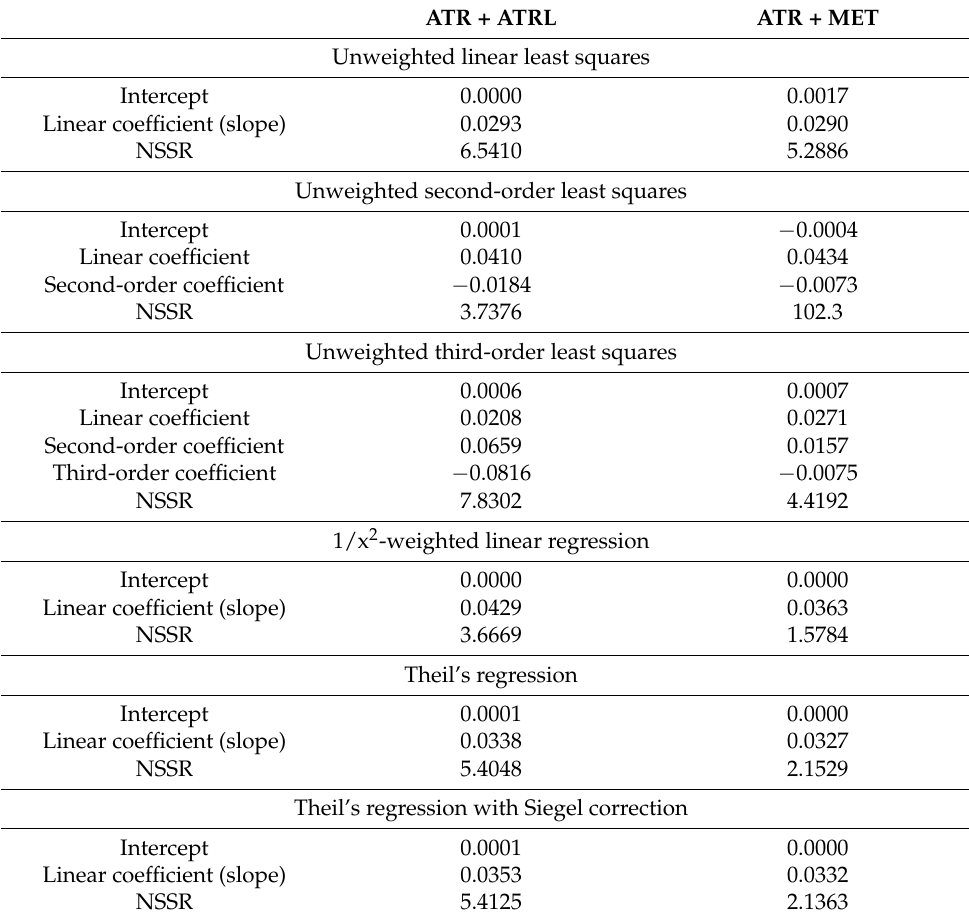
Table 2. Coefficients of the calculated assay error equations and the estimators of the goodness of the fits. ATR, atorvastatin. ATR-L, atorvastatin lactone. 2OATR, 2-hydroxyatorvastatin. 2OATRL, 2-hydroxyatorvastatin lactone. 4OATR, 4-hydroxyatorvastatin. 4OATRL, 4-hydroxyatorvastatin lactone. NSSR, sums of squared residuals normalized to the predicted standard deviations. ATR + ATRL ATR + MET Unweighted linear least squares Intercept 0.0000 0.0017 0.0293